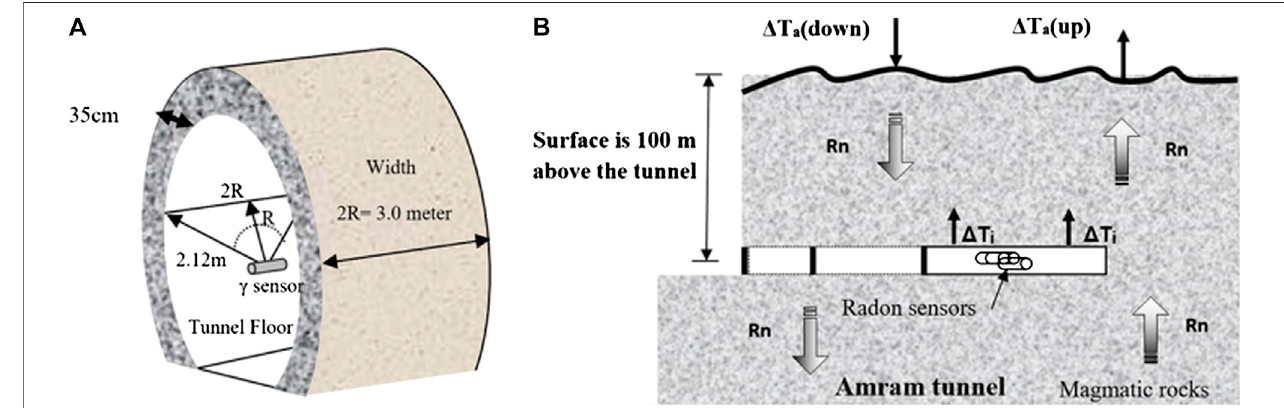
Figure 5 | The Amram tunnel cross-section (A) and scheme (B)